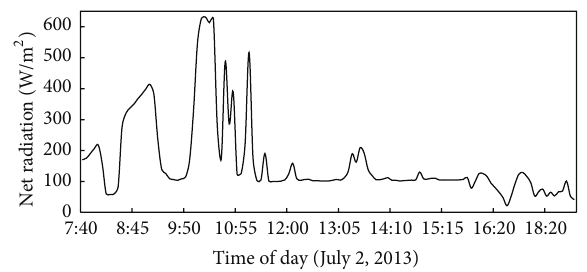
Figure 8: Diurnal variation of the net radiation in the daytime (July 2, 2013).